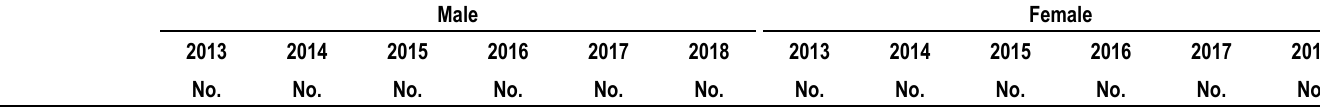
Table 11b. Stage 3 (AIDS) attributed to injection drug use, by selected characteristics, 2013–2018—United States and 6 dependent